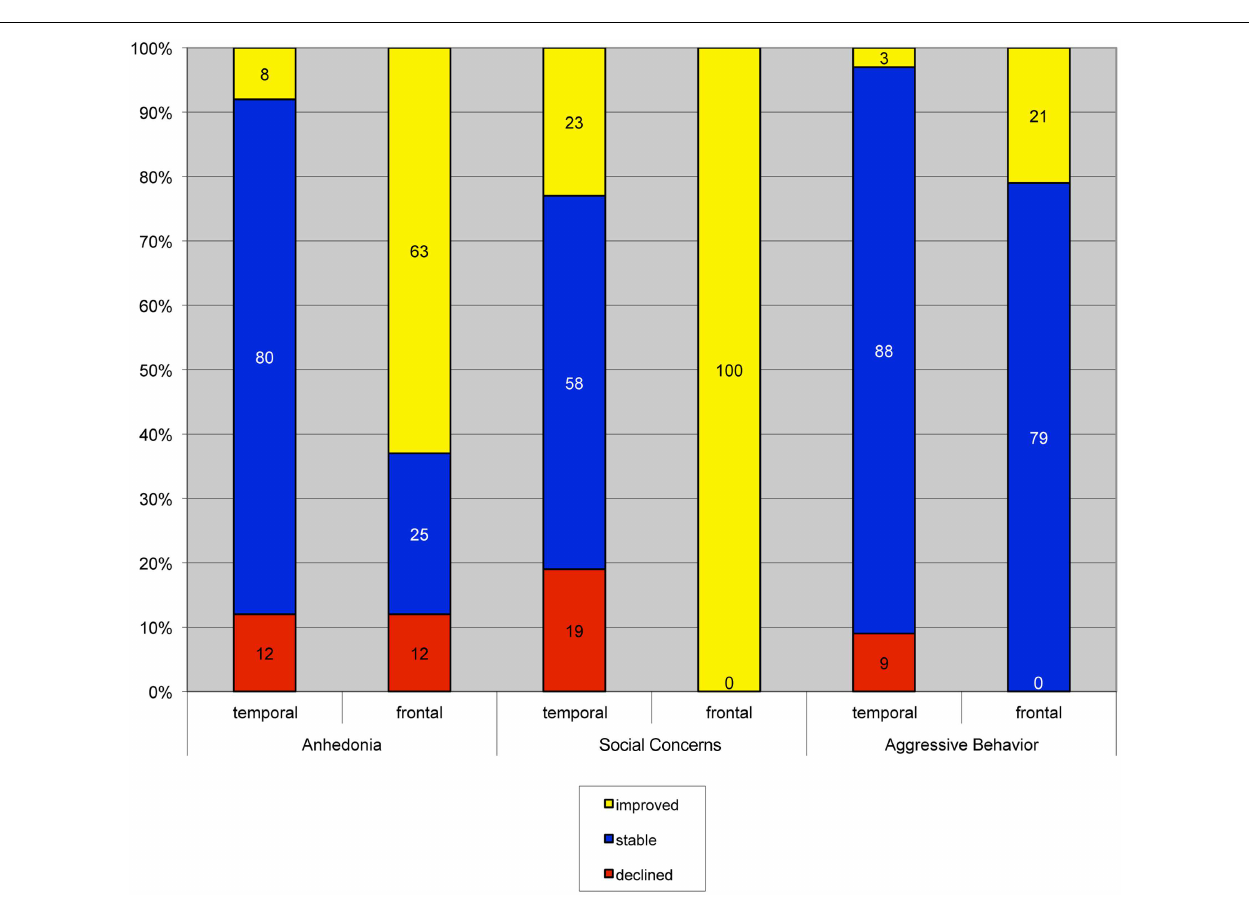
FIGURE 2 | Clinically meaningful change on an individual level in children who underwent left-sided surgeries . Children who received frontal resections had significantly higher rates of clinically significant improvement than children who underwent temporal resections.